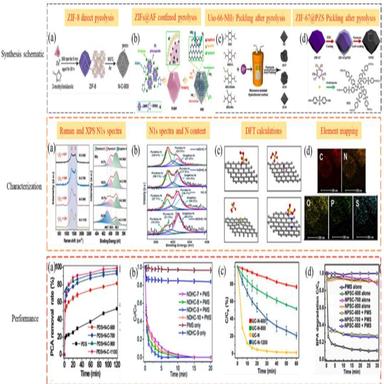
Preparation strategy and performance of MOFs-derived non-metallic heteroatom–doped CMs. (a) The carbonization conditions . Copyright 2020 Elsevier. (b) Nitrogen content and form. Copyright 2019 Royal society of chemistry. (c) Types and morphologies of MOFs precursors. Copyright 2021Elsevier. (d) Ternary non-metal doped MOFs derived CMs . Copyright 2018 Elsevier.